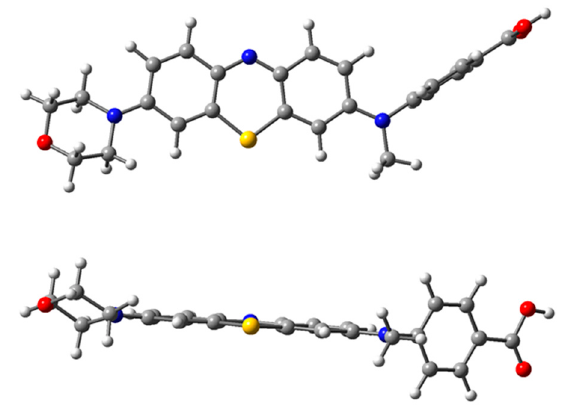
Figure 1. Optimized geometry of the most stable conformer of 3 in the vacuum : front (top) and side (bottom) view; geometry optimization performed with WB97XD functional, 6-31G+(d,p) basis set.